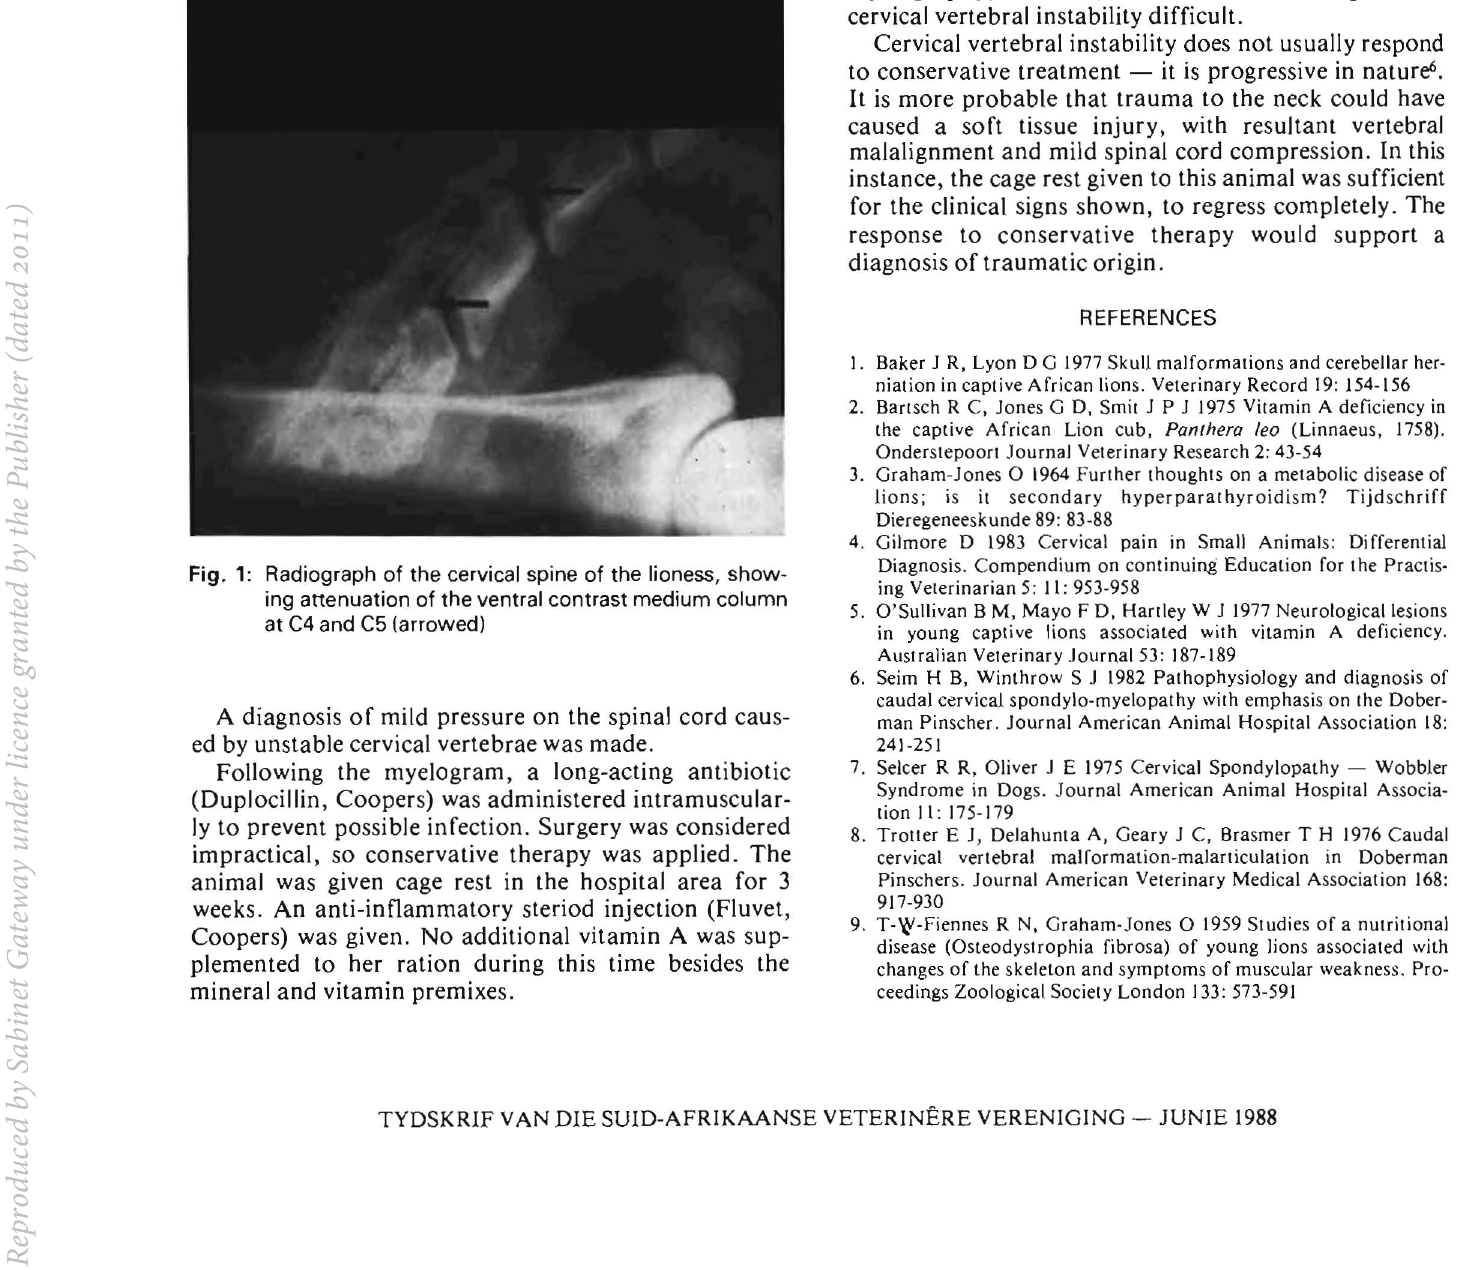
Fig. 1: Radiograph of the cervical spine of the lioness, show ing attenuation of the ventral contrast medium column at C4 and C5 (arrowed)